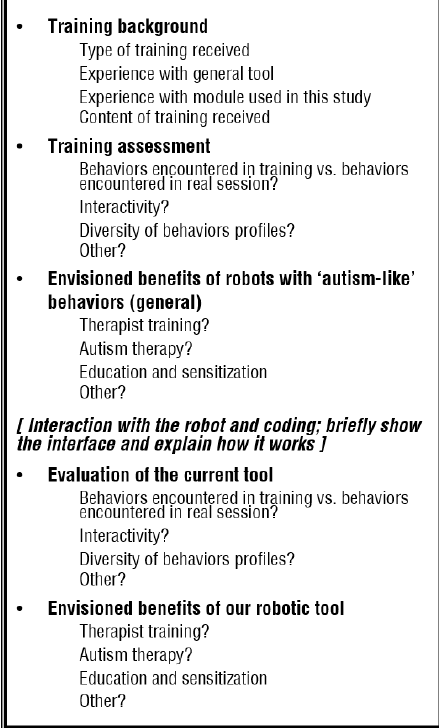
Figure 4: Questionnaire structure. An English version of the full questionnaire is available at